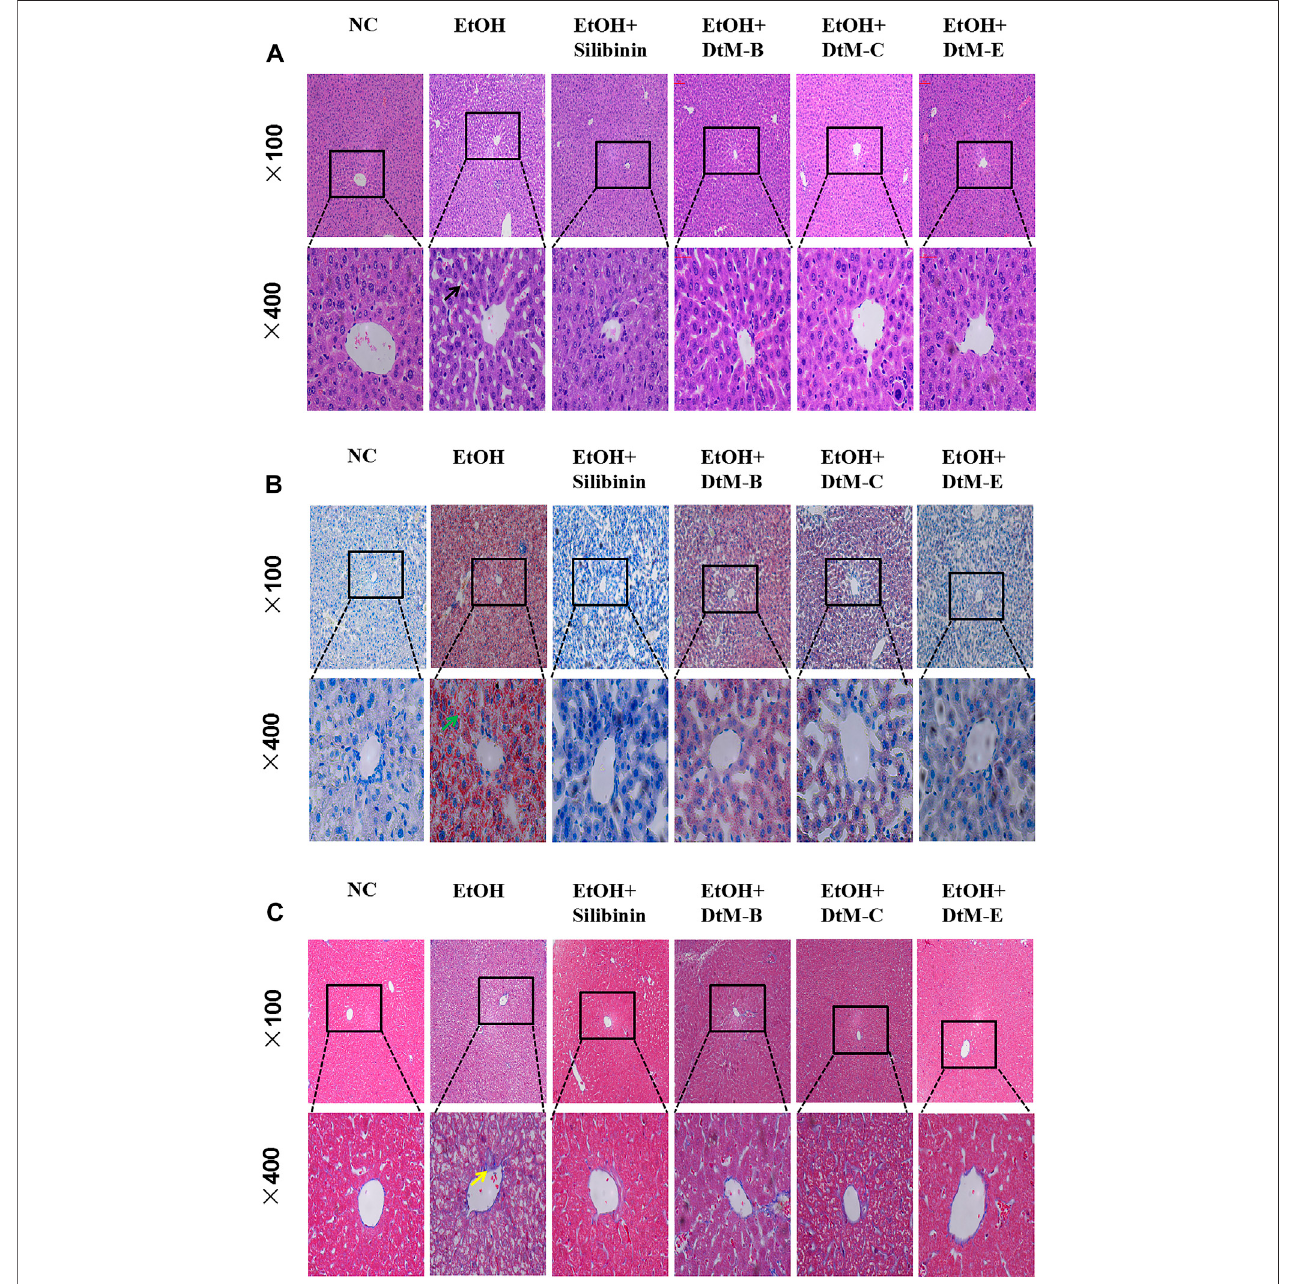
FIGURE 2 | Histological photomicrographs of liver sections stained with hematoxylin and eosin (H&E) (A) , oil red O (B) , and Masson ’ s trichrome (C) ; cell necrosis (black arrow), fatty degeneration (green arrow), fi brosis (yellow arrow).